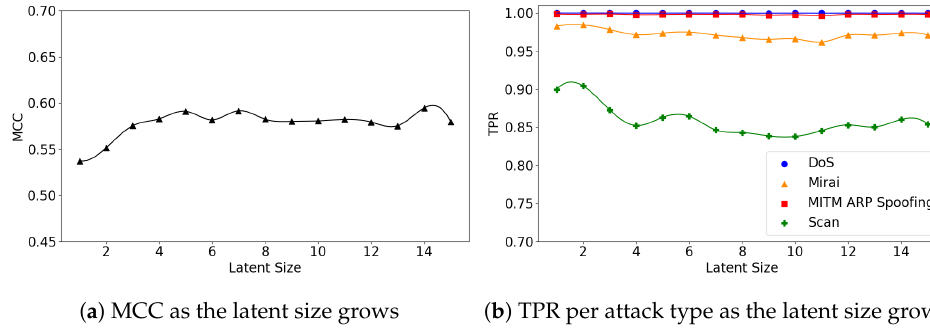
Figure 8. The results of evaluation using the IoTID20 dataset when the (5,32) model is employed.